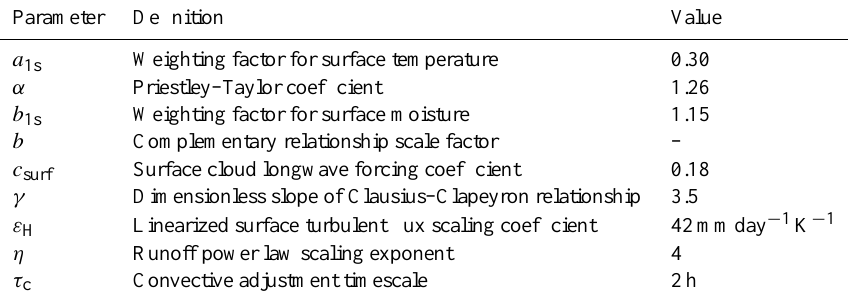
Table 1. Parameter definitions and values in the baseline land–atmosphere coupling